Question: What kind of plot is shown here?
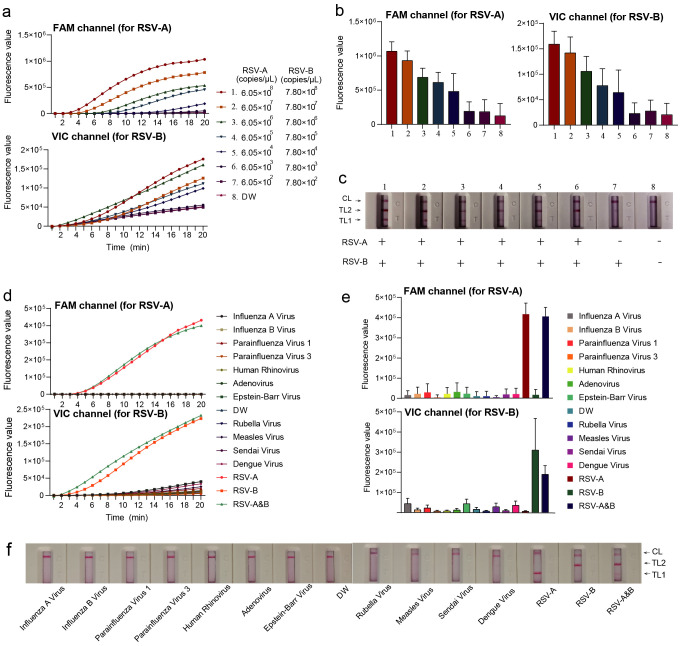
Answer: line